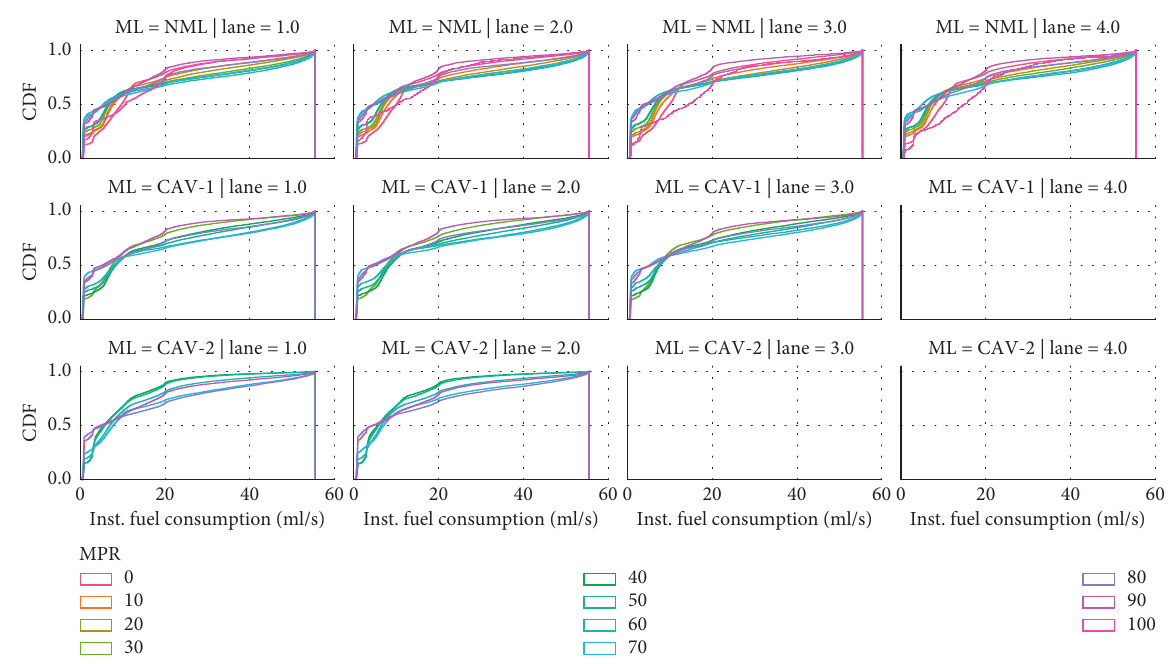
Figure 8: Instantaneous fuel consumption for